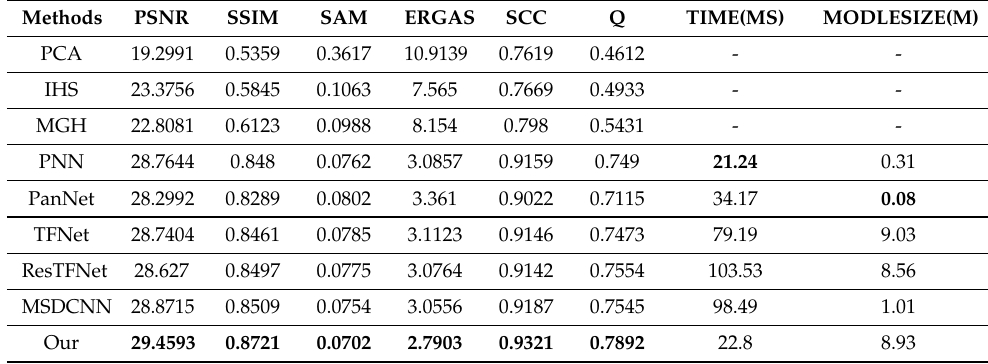
Table 3. Quantitative evaluation on the SPOT6 dataset (bold indicates the best results).